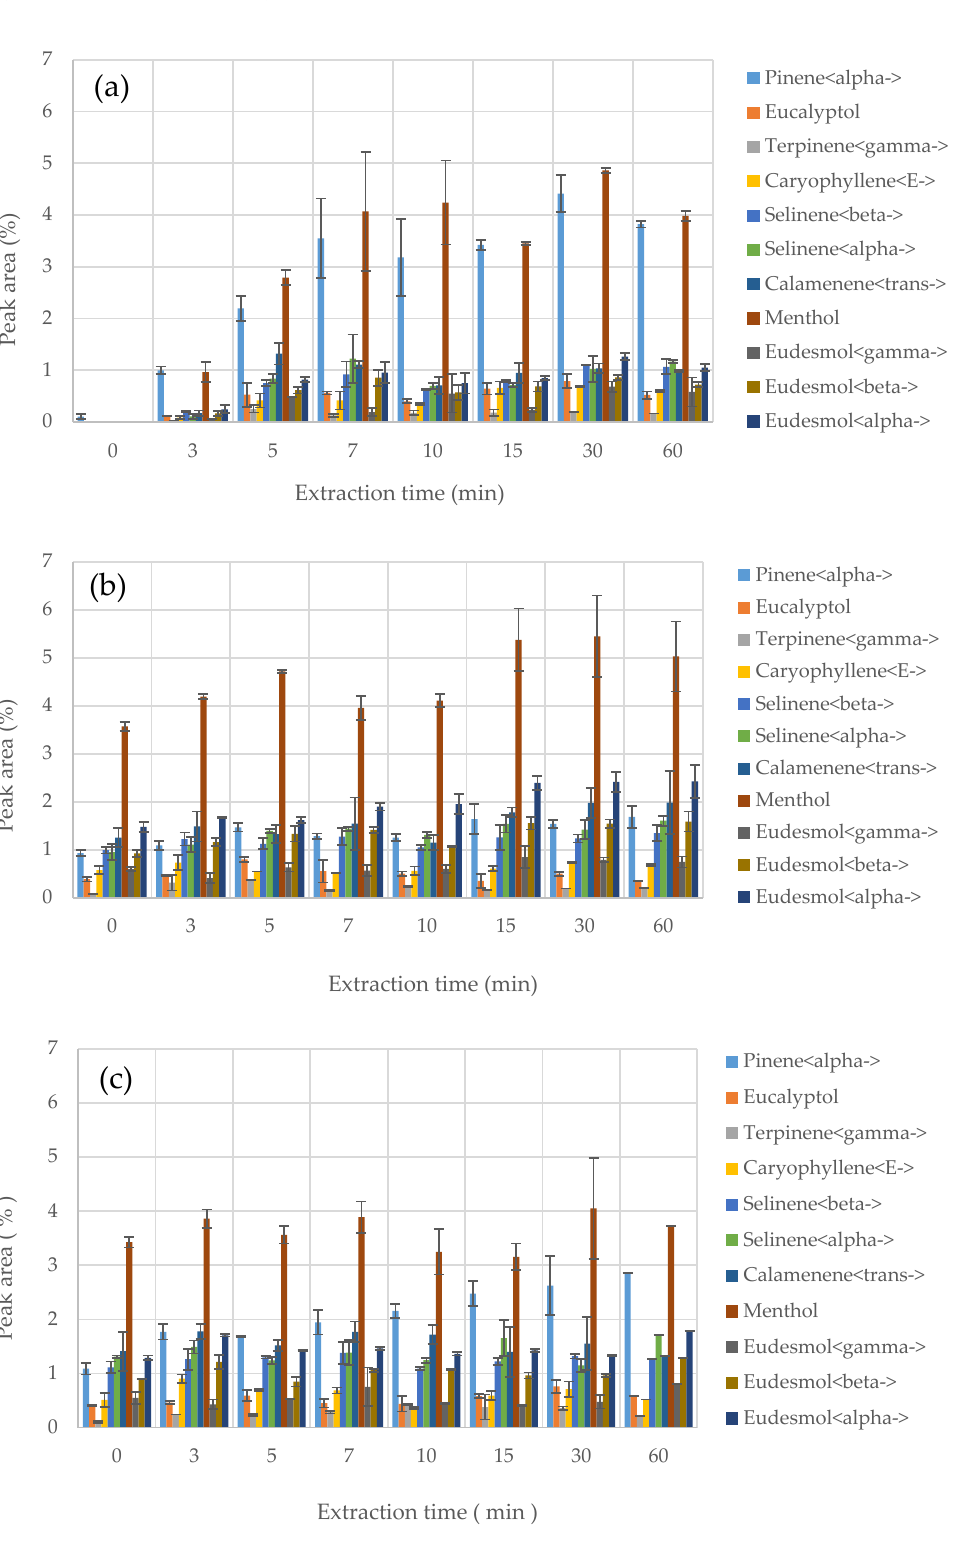
Figure 4. Total of selected bioactive terpenoids in Manuka samples with particle size of: ( a ) d ≥ 250, ( b ) d ≤ 250, ( c ) d ≥ 200 µ